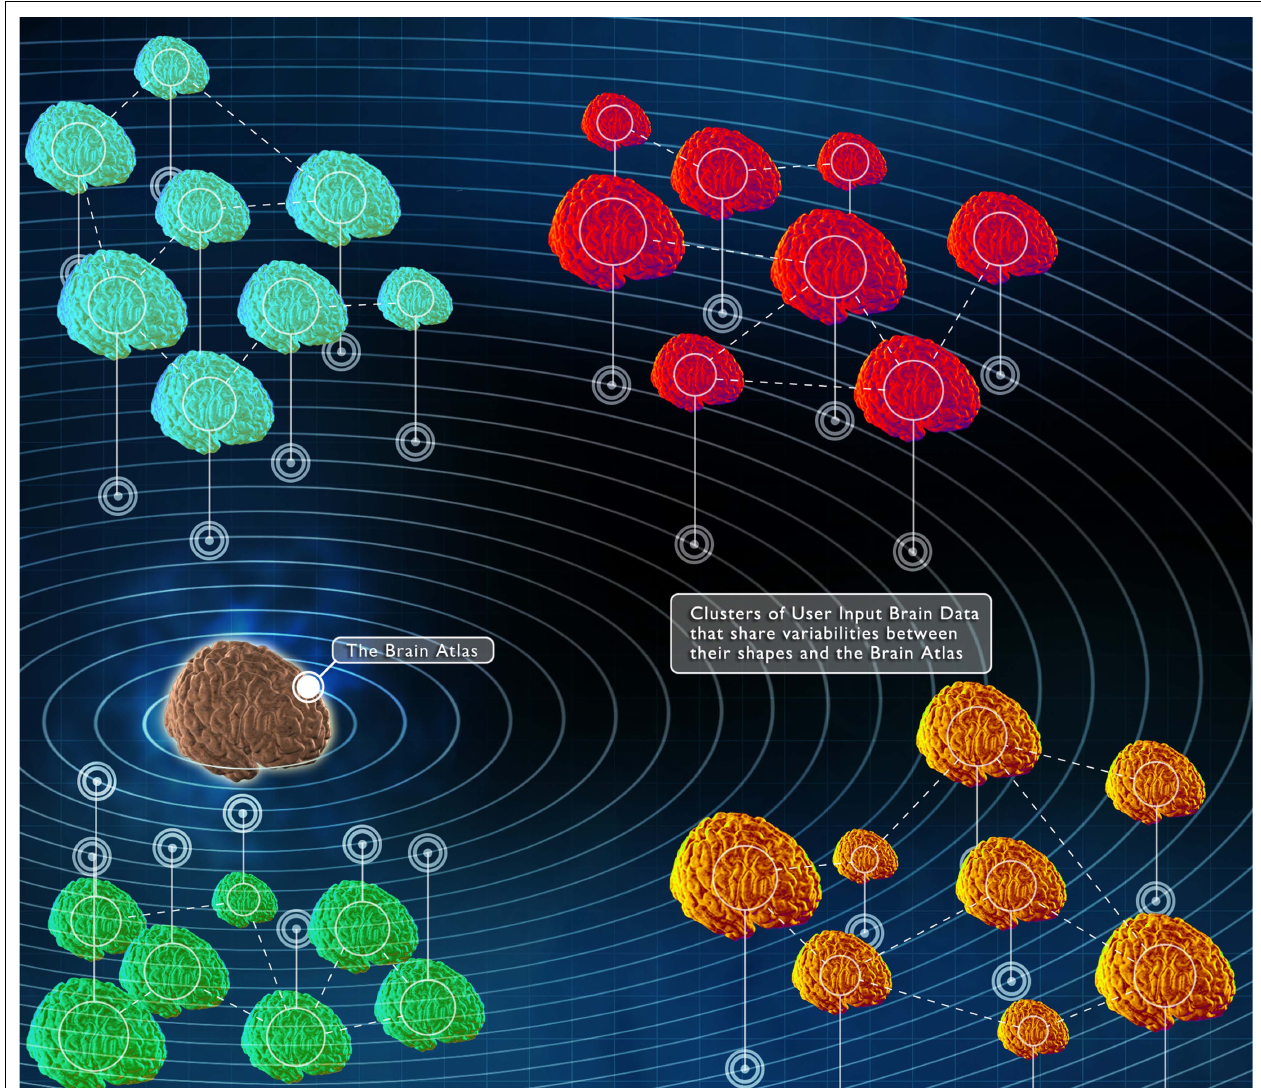
FIGURE 3 | An illustration of distributions of brain surfaces in an atlas meta-space. The atlas can be treated as the origin. The locations of the brain surfaces are derived using MDS applied to the distance matrix of discriminative features. A radial coordinate system is shown for convenience, in practice any other informative reference frame can be